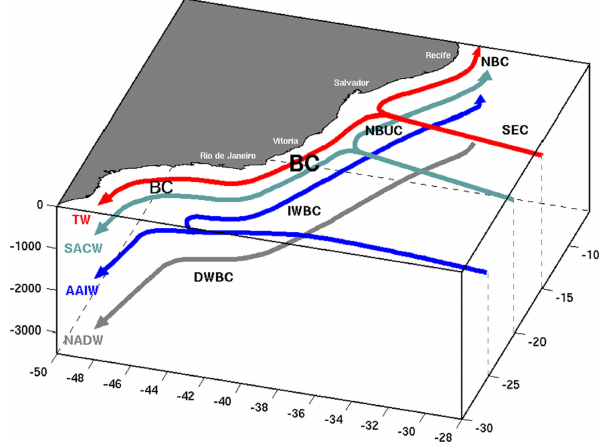
Figure 1. 3-D schematic of the South Atlantic western boundary circulation and water masses from Soutelino et al. (2013). The wa- ter masses associated with the SAMOC upper limb are represented by Tropical Water (TW), South Atlantic Central Water (SACW), and Antarctic Intermediate Water (AAIW). The circulation is repre- sented by the Brazil Current (BC), Intermediate Western Bound- ary Current (IWBC), North Brazil Undercurrent (NBUC), North Brazil Current (NBC), and South Equatorial Current (SEC). The Deep Western Boundary Current (DWBC) is also shown flowing poleward along the NADW